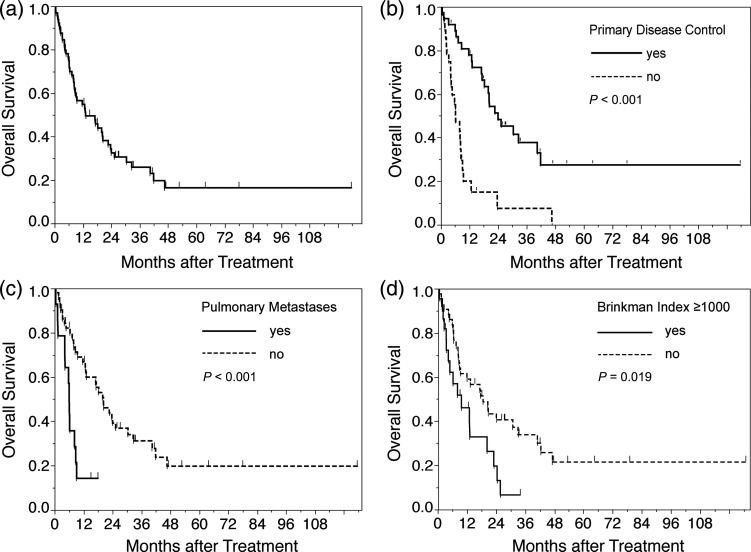
Overall survival. (a) Overall survival and Kaplan–Meier survival curves for prognostic factors. (b) Survival curves by primary disease control. (c) Survival curves by pulmonary metastases. (d) Survival curves by Brinkman index.